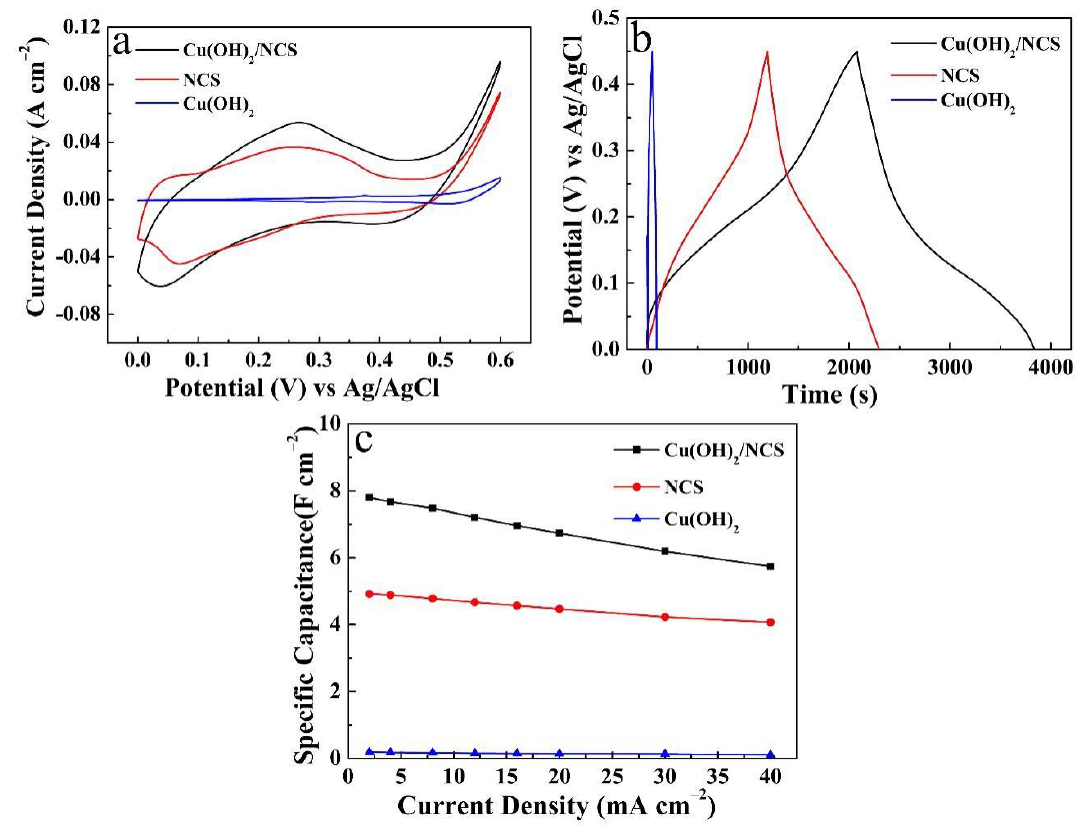
Figure 4. Performances comparison of Cu(OH) 2 /NCS, NCS, and Cu(OH) 2 electrode: ( a ) CV curves; ( b ) GCD curves at different current densities and corresponding C s ( c ). ( b ) GCD curves at different current densities and corresponding C s ( c